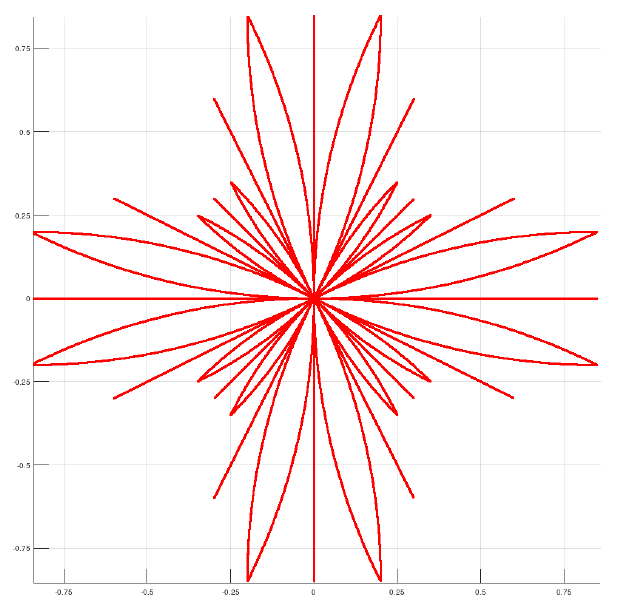
Figure 9. Control set used for the search-based planner. Axis values are shown in